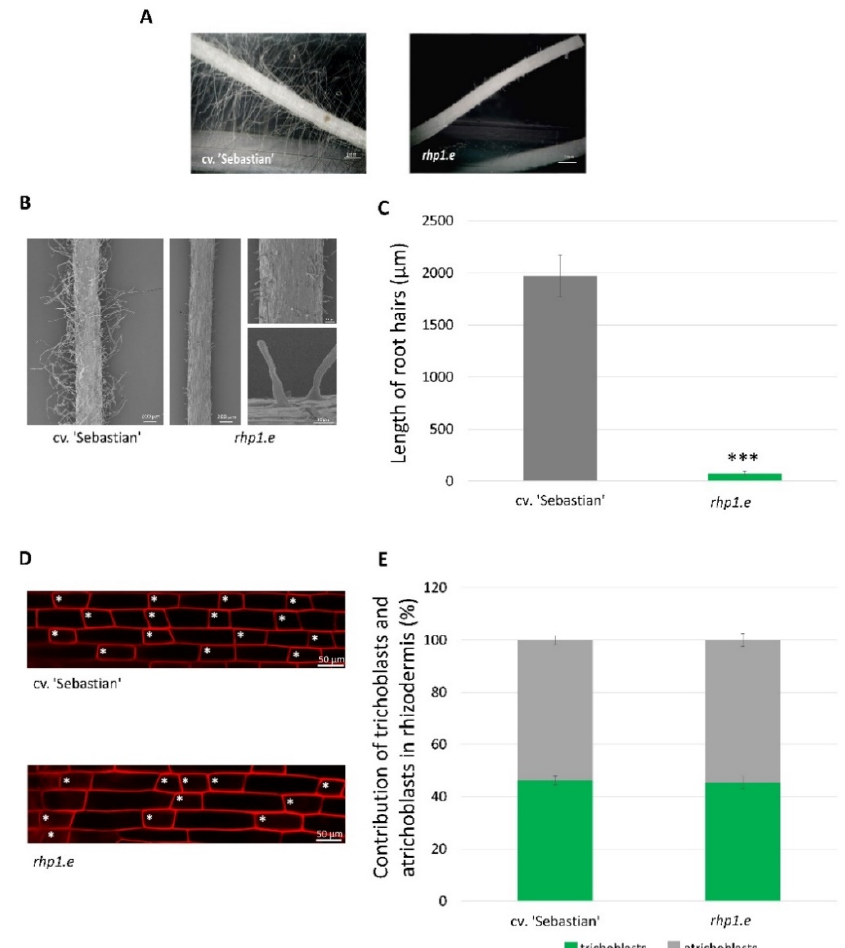
Figure 1. Root hair phenotype of WT cv. ‘Sebastian’ and rhp1.e mutant. ( A ) Light microscope and ( B ) SEM images of the root hair zone of WT and rhp1.e. ( C ) Length of the root hairs in the WT and mutant. Significant differences were calculated using Student’s t -test (*** p < 0.001). Graph shows mean of n = 500 root hairs per each genotype with SD. ( D ) Rhizodermis patterning in WT cv. ‘Sebastian’ and rhp1.e mutant. Optical sections through the rhizodermal layer and proportions of the two types of cell present in the root epidermis. Stars indicate trichoblasts. ( E ) Proportion of trichoblasts and atrichoblasts in rhizodermis of WT ‘Sebastian’ and rhp1.e